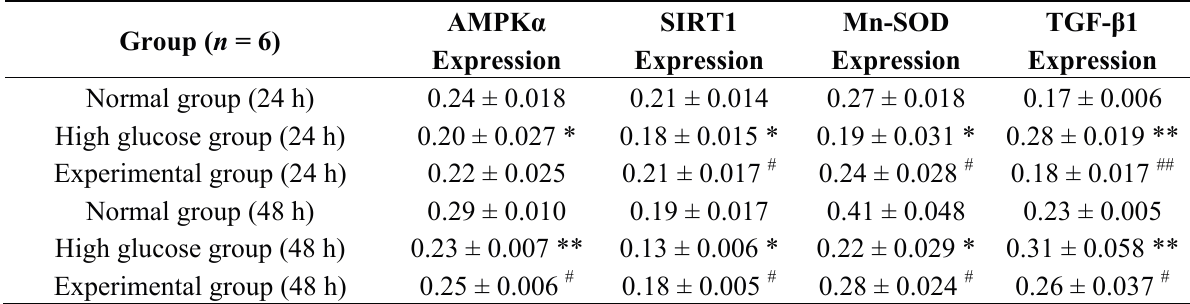
Table 1. Effect of GA on silent information regulator T1 (SIRT1), AMP-activated protein kinase α (AMPK α ), manganese-superoxide dismutase (Mn-SOD) and transforming growth factor- β (TGF- β 1) proteins expression in NRK-52E cells, as detected by immunohistochemistry. AMPK α SIRT1 Mn-SOD TGF- β 1 Group ( n = 6) Expression Expression Expression Expression Normal group (24